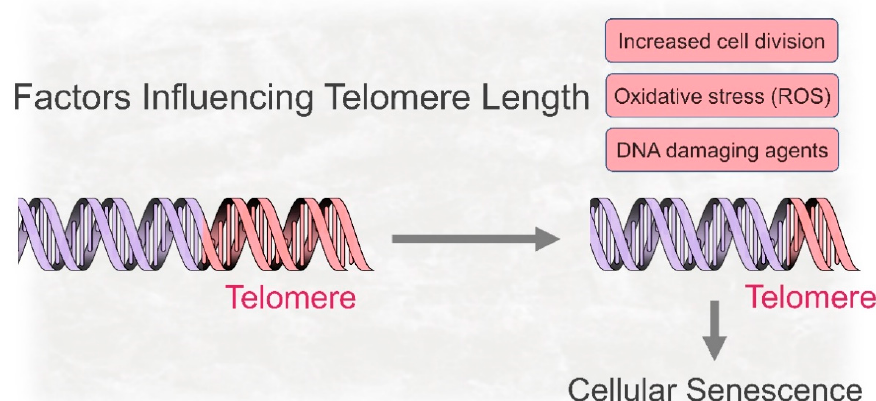
Figure 1. Telomere dependent and independent factors contribute to the onset of cellular senescence.